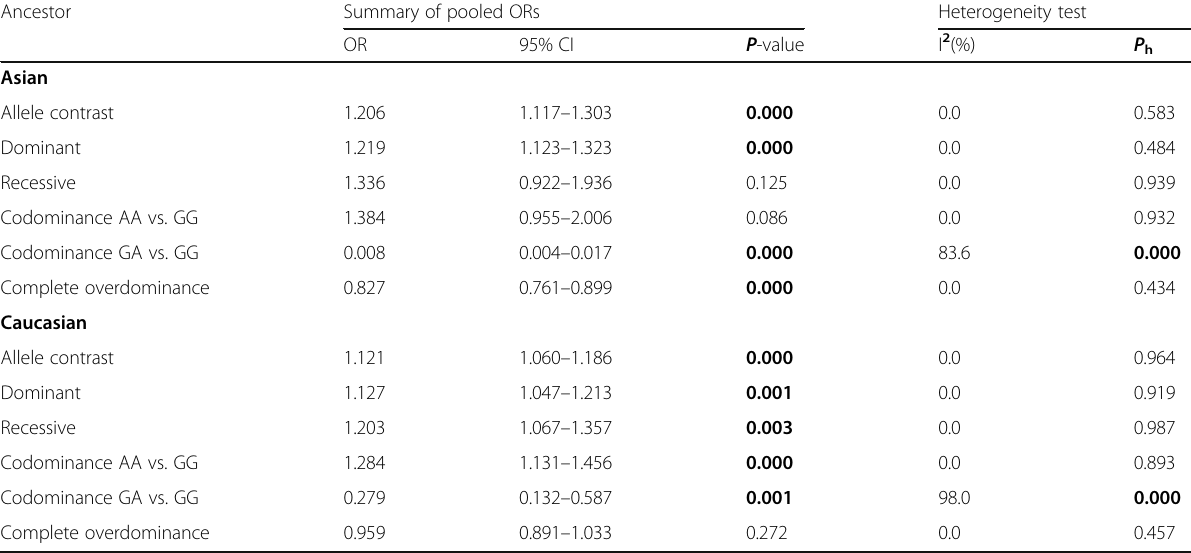
Table 4 Subgroup analysis of the association between rs1006737 and the risk of schizophrenia Ancestor Summary of pooled ORs